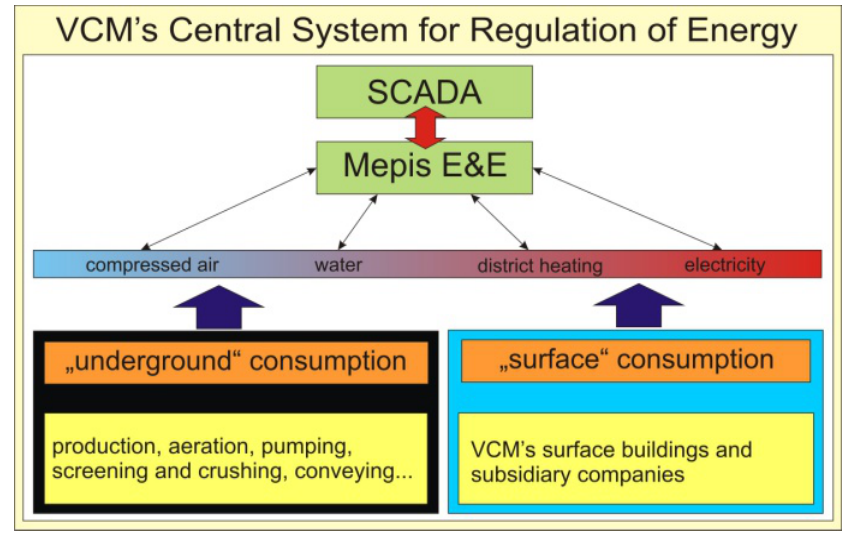
Figure 1. Schematic representation of CSRE structure and monitored energy sources by location and users.